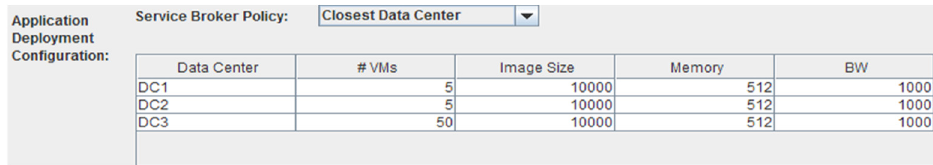
Figure 8. Application deployment configuration of Data Centers 1 to 3 based on CDC SBP.